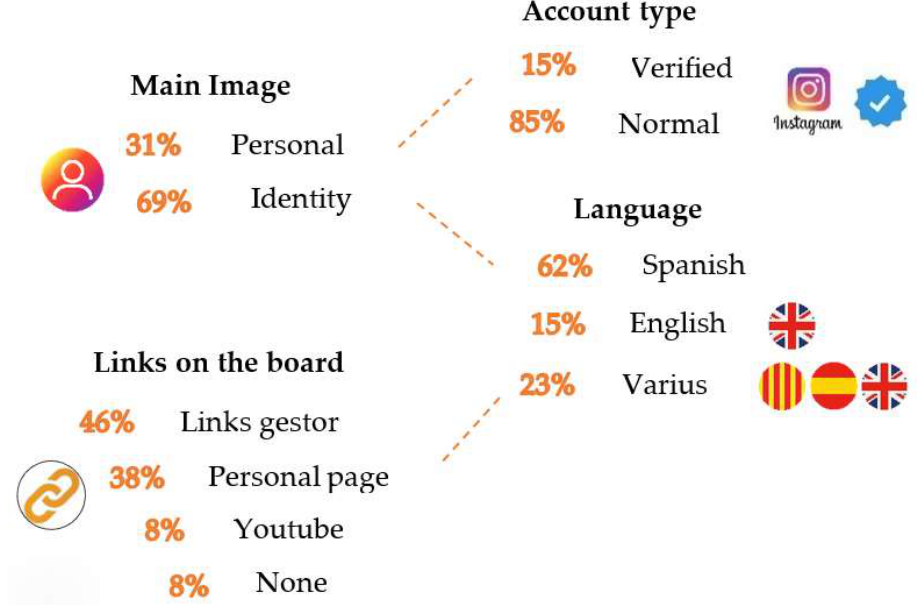
Figure 1. Characterization of the accounts. Source of own elaboration.